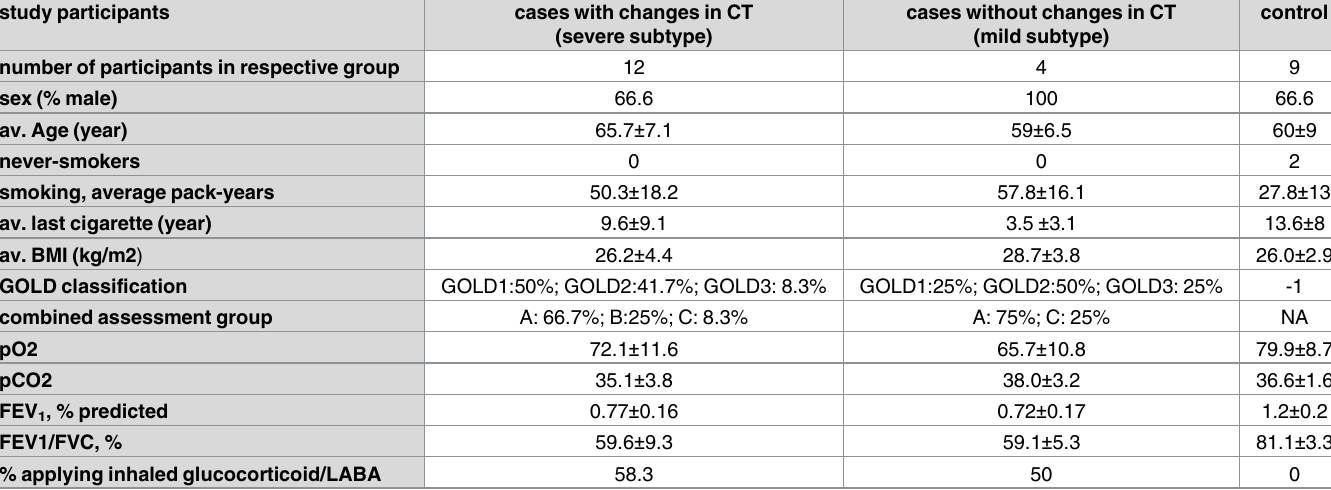
Table 1. Clinical, spirometry and laboratory comparisons of patients and controls. Data presentedas mean ± SD, unless otherwiseindicated. Abbrevi- ations: av. last cigarette (years): averageyears study participantsstoppedsmoking before bronchoscopy procedure.BMI: body mass index. pO 2 : partial pres- sure of oxygen. pCO 2 : partial pressureof carbon dioxide.FEV 1 : forced expiratory volume in 1s. FVC: forced vital capacity. LABA: long-actingbeta-2